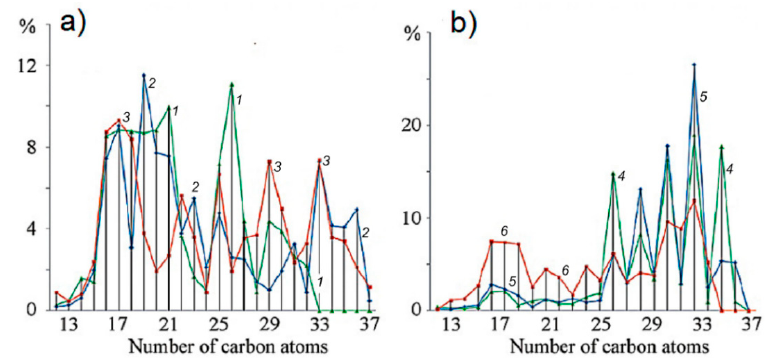
Figure 13. The composition of alkanes (% of total) in the snow samples at (( a ), 1 , 2 ) Molodezhnaya and Novolazarevskaya stations: ( 3 ) Glubokoe Lake, (( b ), 4 , 5 )) Geodezistov Lake, and ( 6 ) Verkhnee Lake.